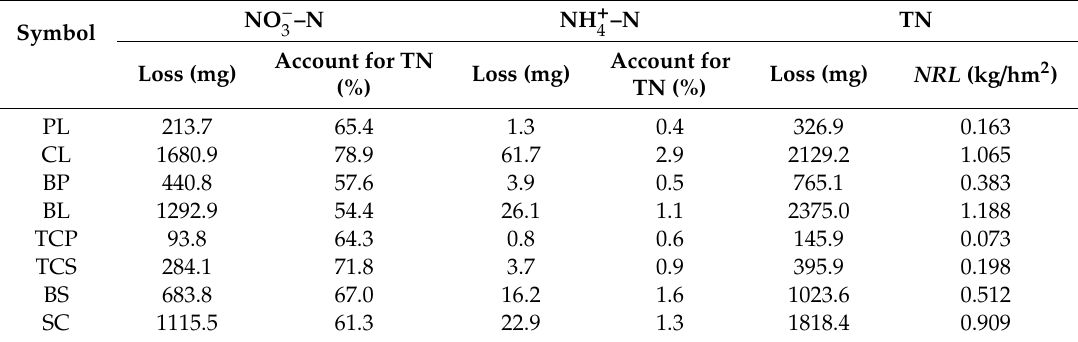
Table 2. Characteristics of nitrogen loss in runo ff under di ff erent crop